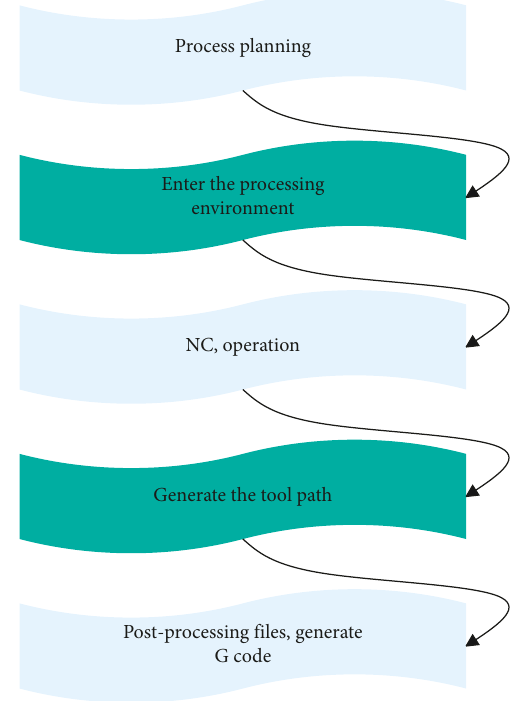
Figure 1: General flow of CNC